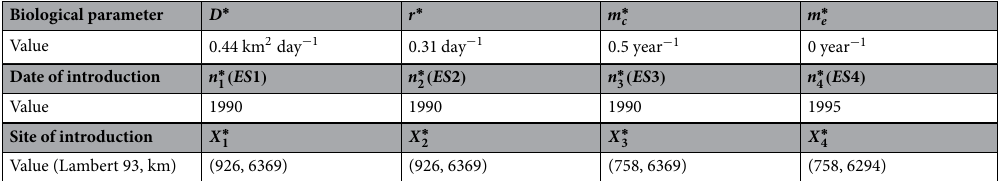
Table 2. Maximum likelihood estimates.